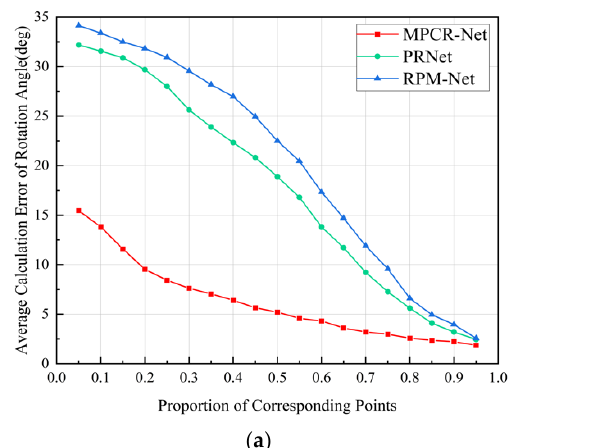
Figure 12. Average time of MPCR-Net, PRNet, and RPM-Net under different proportions of correspondence points.